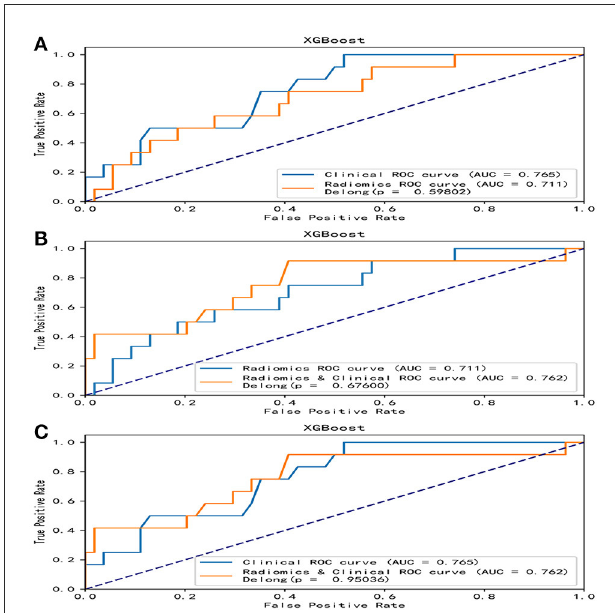
FIGURE7 Comparative analysis of ROC in the XGBoost model. In the XGBoost model, there were no statistical differences in the models based on clinical features, radiomics features, and combined features. (A) A DeLong test was used to compare the clinical model and the radiomics model. P = 0.598. (B) A DeLong test was used to compare the radiomics model and the combined model. P = 0.676. (C) The DeLong test was used to compare the clinical model and the combined model. P = 0.950. ROC, receiver operating characteristic; RF, random